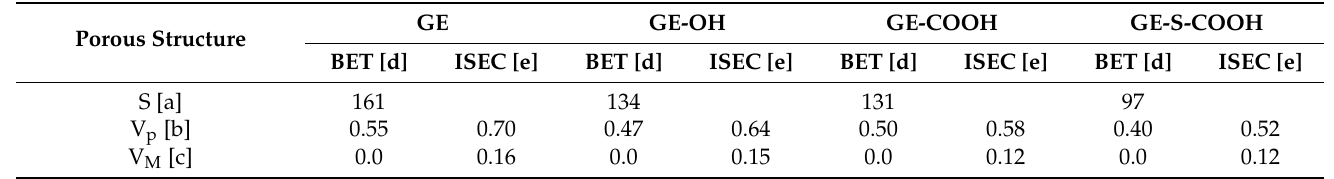
Table 8. Porous structure of chemically modified copolymers.